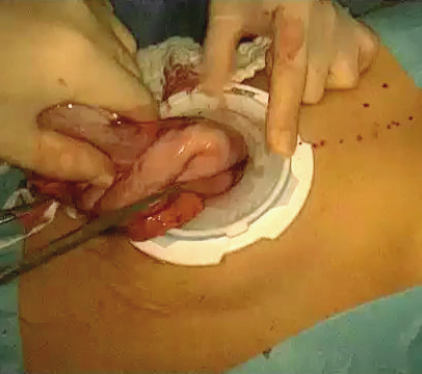
Figure 3: Removal of the specimen through the umbilical port.